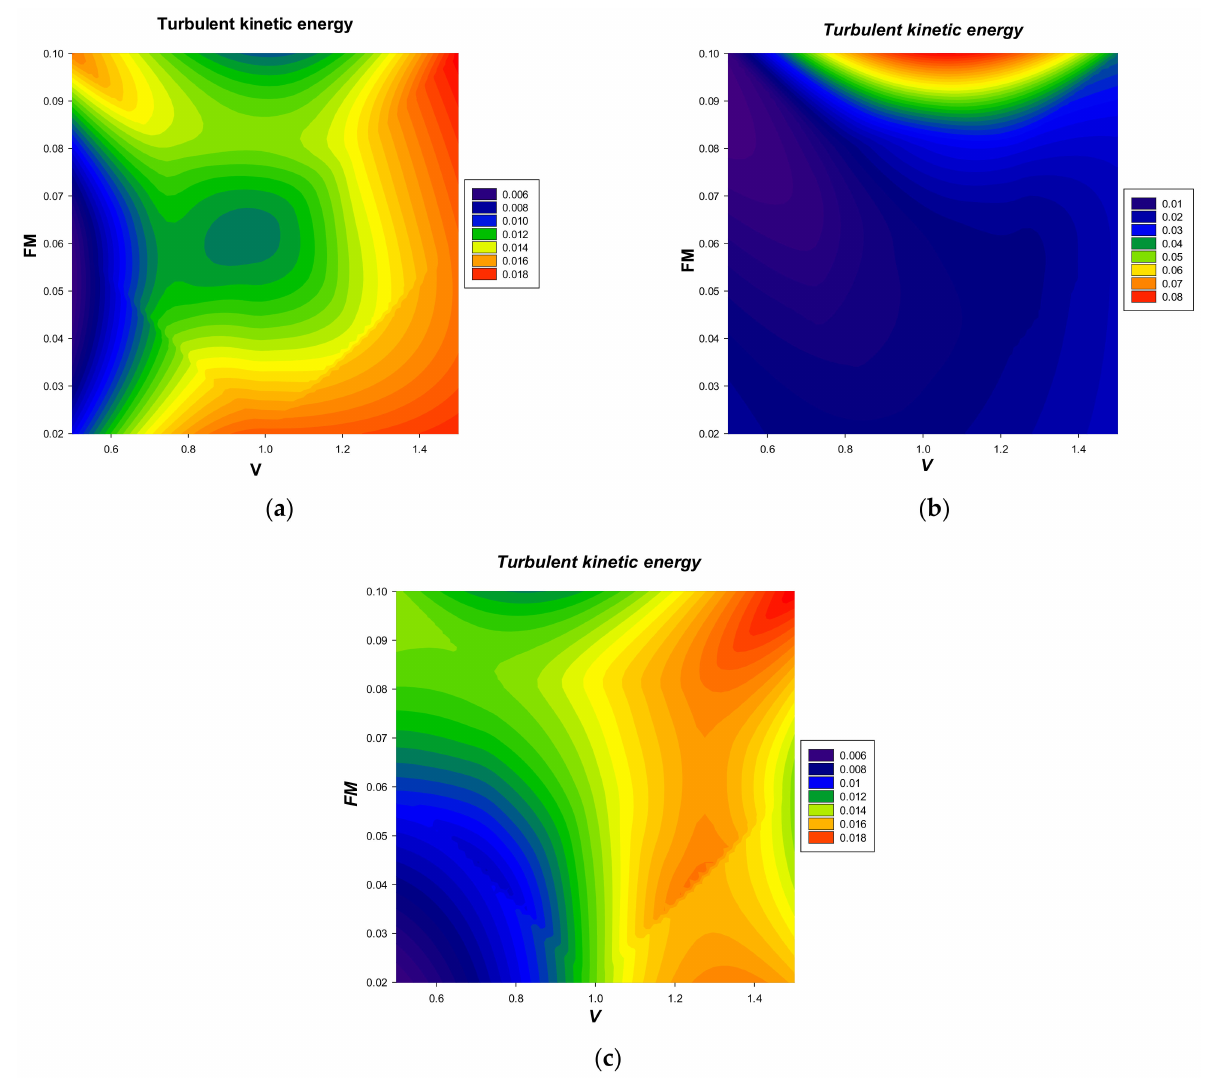
Figure 10. ( a ) conical, ( b ) middle, and ( c ) average upper turbulent kinetic energy on 2D plots as a function of feed gas velocity and total mass of mixing